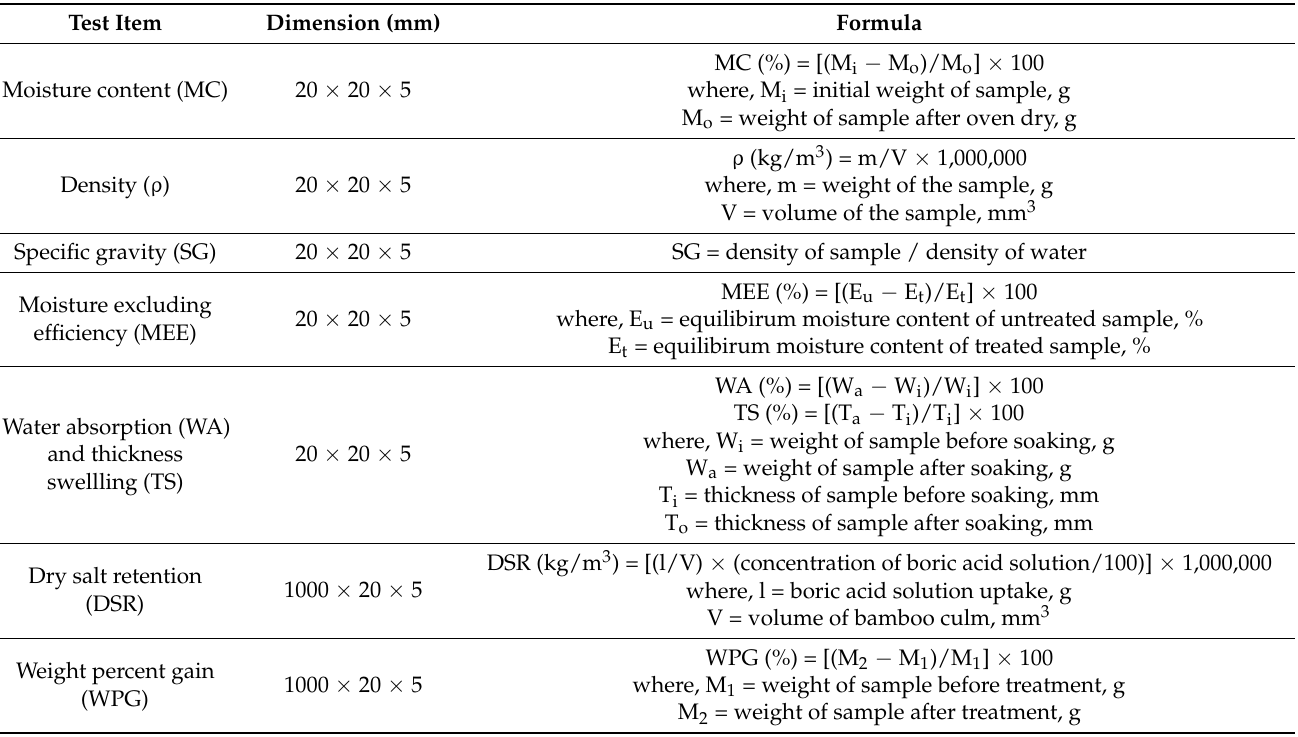
Table 1. Experimental test methods of bamboo strips for the determination of physical